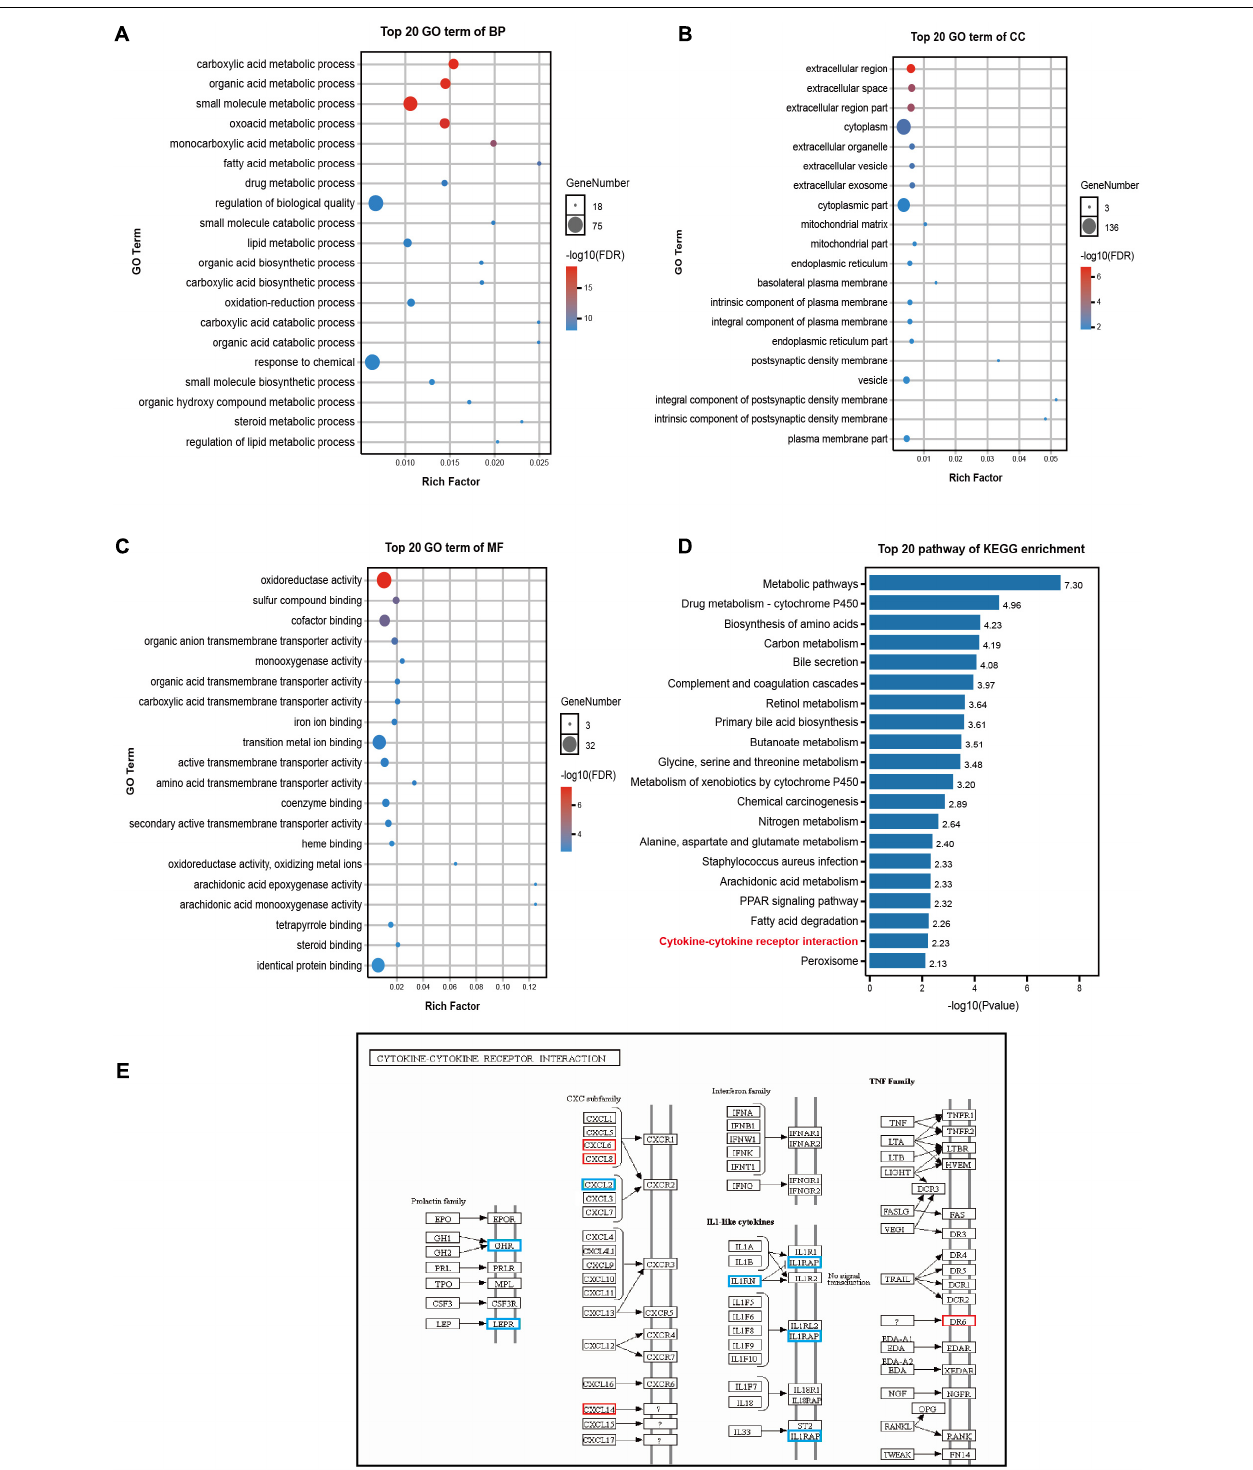
FIGURE 4 | GO and KEGG pathway enrichment analyses of DEGs. (A–C) The 20 most significant GO terms under the BP, CC, and MF categories. The X -axis represents the rich ratio while the Y -axis highlights the GO term names. The color of the bubbles indicates the adj. p value. The range from red to blue represents low to high. The size of the bubbles represents the number of genes enriched in the term. BP, biological processes; CC, cellular component; MF, molecular function. (D) The top 20 pathways enriched as per KEGG. (E) DEGs of the chemokine-chemokine receptor interaction pathway. Red represents up-regulation in ACLF; blue represents